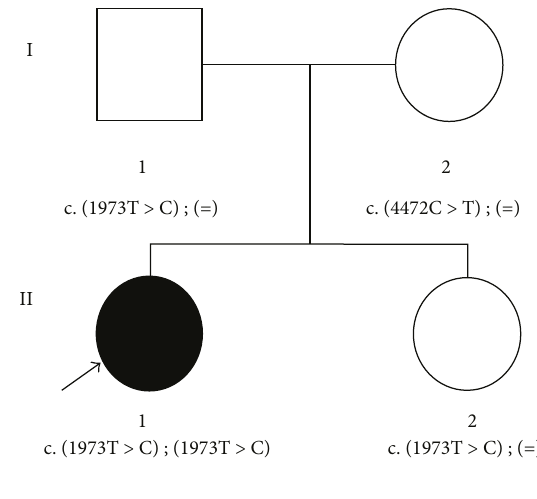
Figure 1: Pedigree of the a ff ected Family 1 with congenital SNHL. Sanger sequencing analysis showed that patient II1 had the compound heterozygous mutation (c.[1973T > C]; c.[4472C > T]), and the parents and sister had the heterozygous mutation. The patient is denoted in black. [=] means wild